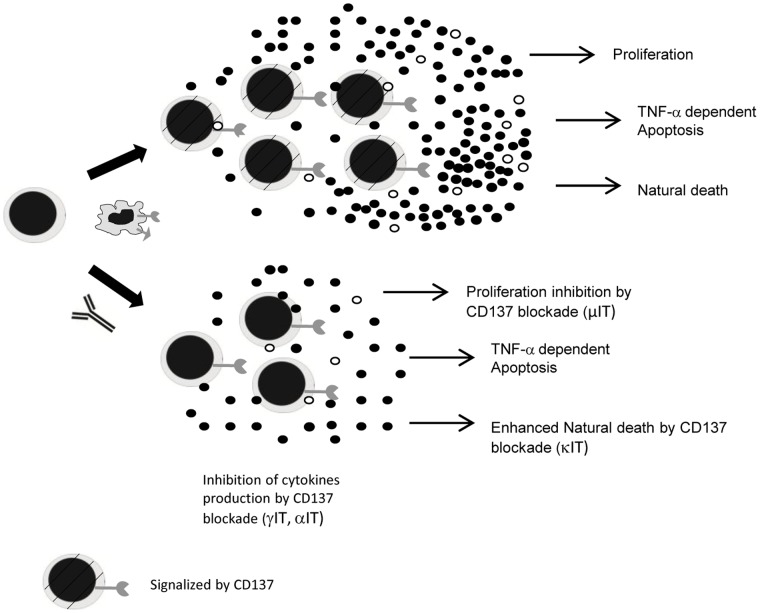
Diagram of TL dynamics in the in vitro culture.Four different TL subpopulations are described: non-specific-antigen-T cells (Tns), specific-antigen naïve T cells (T0), activated and CD137 co-stimulated cells (Ts); and activated T cells with blocked CD137 (Tb). Rows indicate possible mechanisms for each subpopulation. Tn population only proliferates and dies. T0 dynamics also includes proliferation and natural death at the same rate as Tn, and can undergo activation/differentiation (and became Ts or Tb) dependent on the presence of activated APC (Aa, As, As_Ab and AAb). During activation, T cells express the receptor and, depending on the concentration of anti-CD137 mAb in the media, a portion of them can become blocked. Prior estimates indicate that CD137 signals delivered by agonistic antibodies or by overexpressed ligands can augment T-cell activation or survival. CD137 is not expressed on resting T cells, but rather is induced with antigen (Ag)-receptor signaling. Ts dynamics account for the differentiation of naïve LT0, proliferation, natural death and TNF-α induced apoptosis. Tbl dynamics incorporates apoptosis induced by CD137 blockage, inhibition and proliferation of IFN-γ and TNF-α production. The model assumes that all activated TL express the receptor.